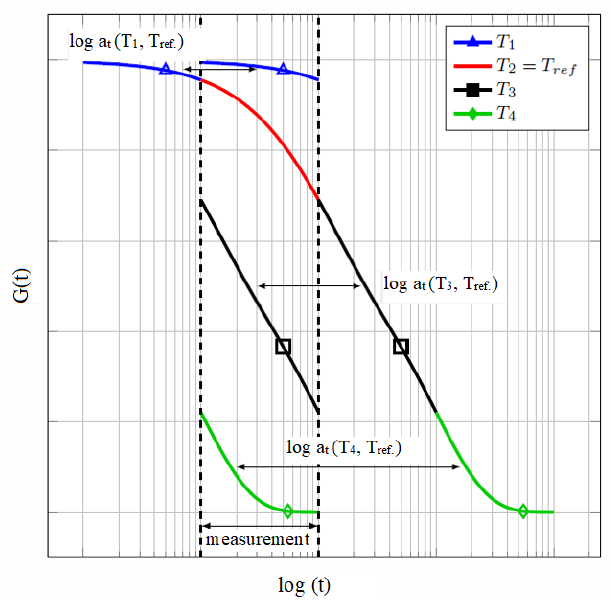
Figure 2. Time–temperature superposition principle master curve [29], T 1 < T 2 < T 3 < T 4 .